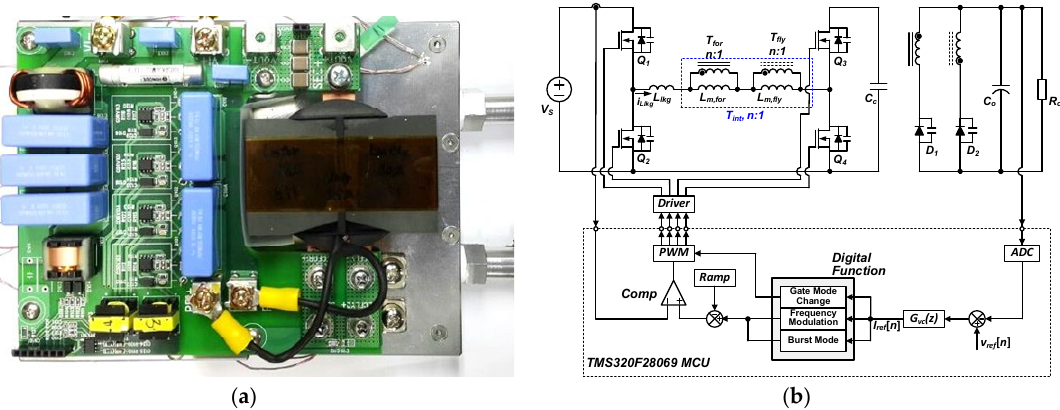
Figure 11. Prototype and control block diagram of proposed converter. ( a ) Prototype. ( b ) Control block diagram.